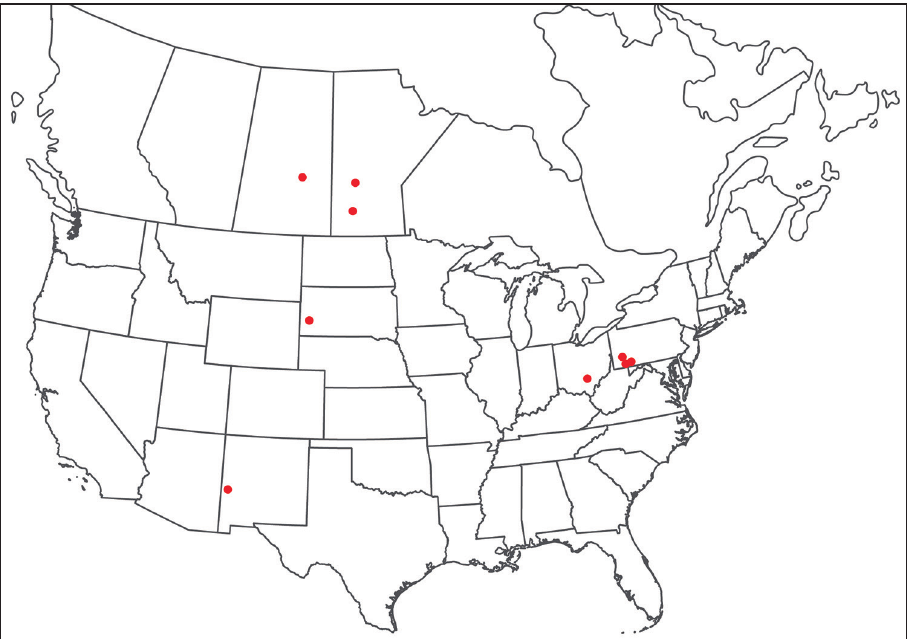
Figure 231. Torrenticola sellersorum sp. n.